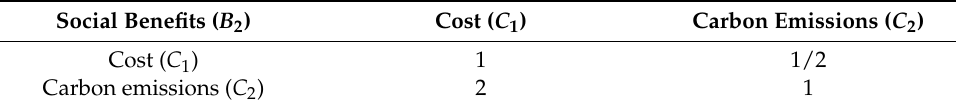
Table 6. Matrix relationship between layer C and layer B 2 .